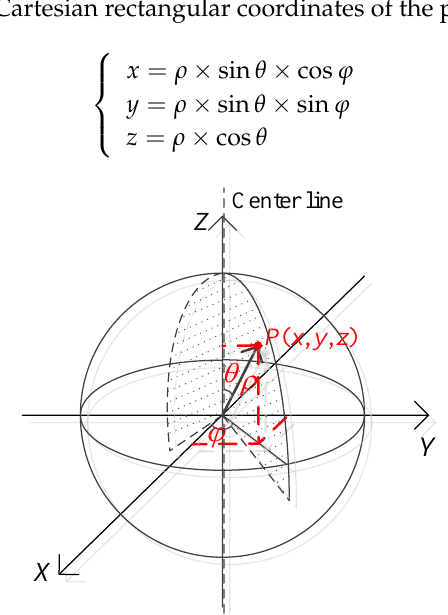
Figure 3. Coordinate system in the ideal situation.